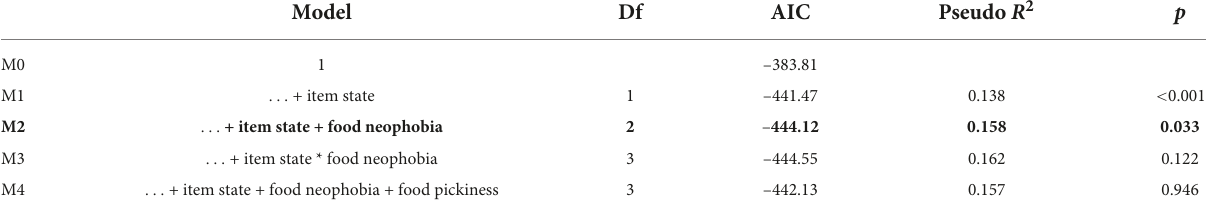
TABLE 5 The goodness of fit of the linear mixed-effects models with A (cid:48) as the outcome measure.